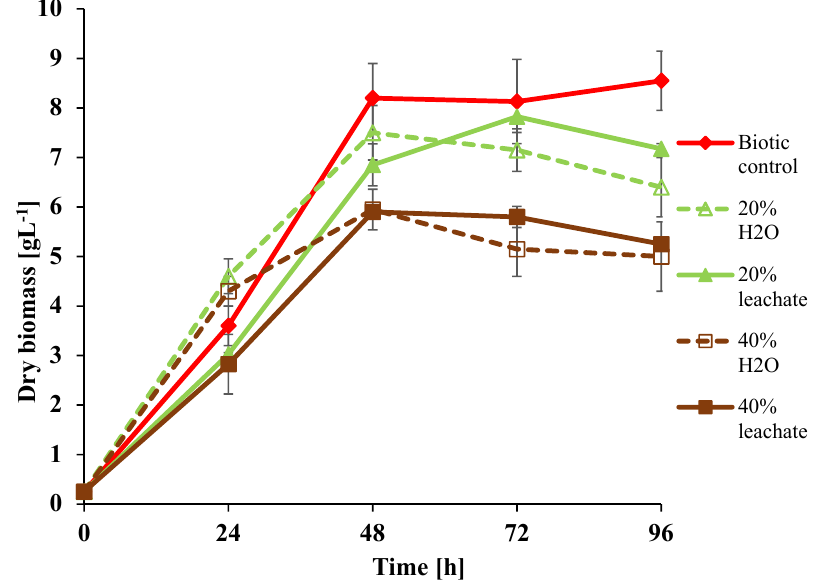
Figure 2. Effect of supplementation with landfill leachate (20% and 40% of the volume) on the growth of U. isabellina during 96 h of incubation.